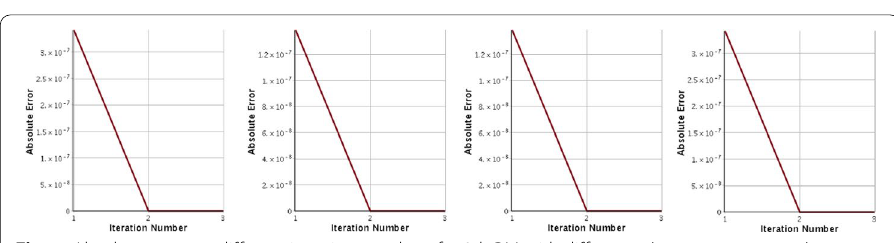
Fig. 5 Absolute errors at different iteration numbers for 8th BM with different θ ( θ = − 1, − 0.5,0.5,1 ) respectively for g 5 ( x )